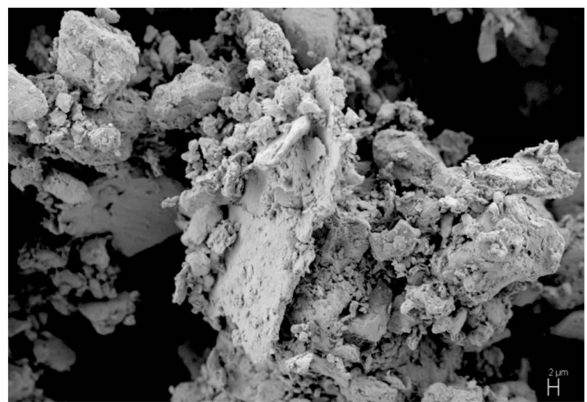
Figure 1. Morphology of the powder agglomerates obtained by ball milling of Ti 25 Cu 75 alloy ribbons with carbon black.